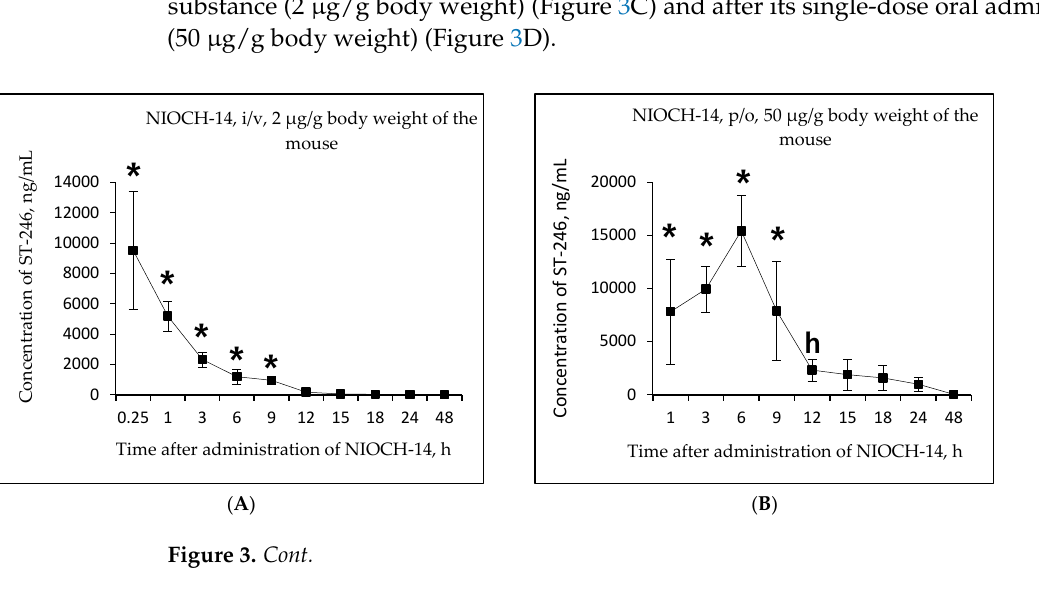
Table 4. Pharmacokinetic parameters of the active metabolite ST-246 in mouse serum and organs upon single-dose oral administration of NIOCH-14 (50 µg/g).